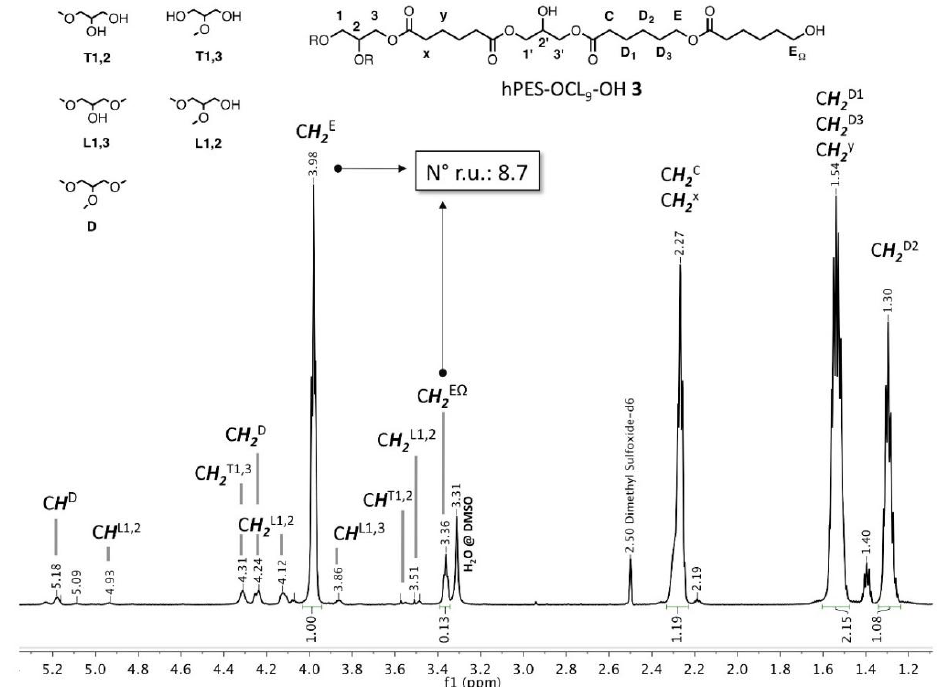
Figure 4. 1 H NMR of hPES-OCL 9 -OH 3 showing peak assignment and crucial methylene signals for determination of number of repeating units of caprolactone.